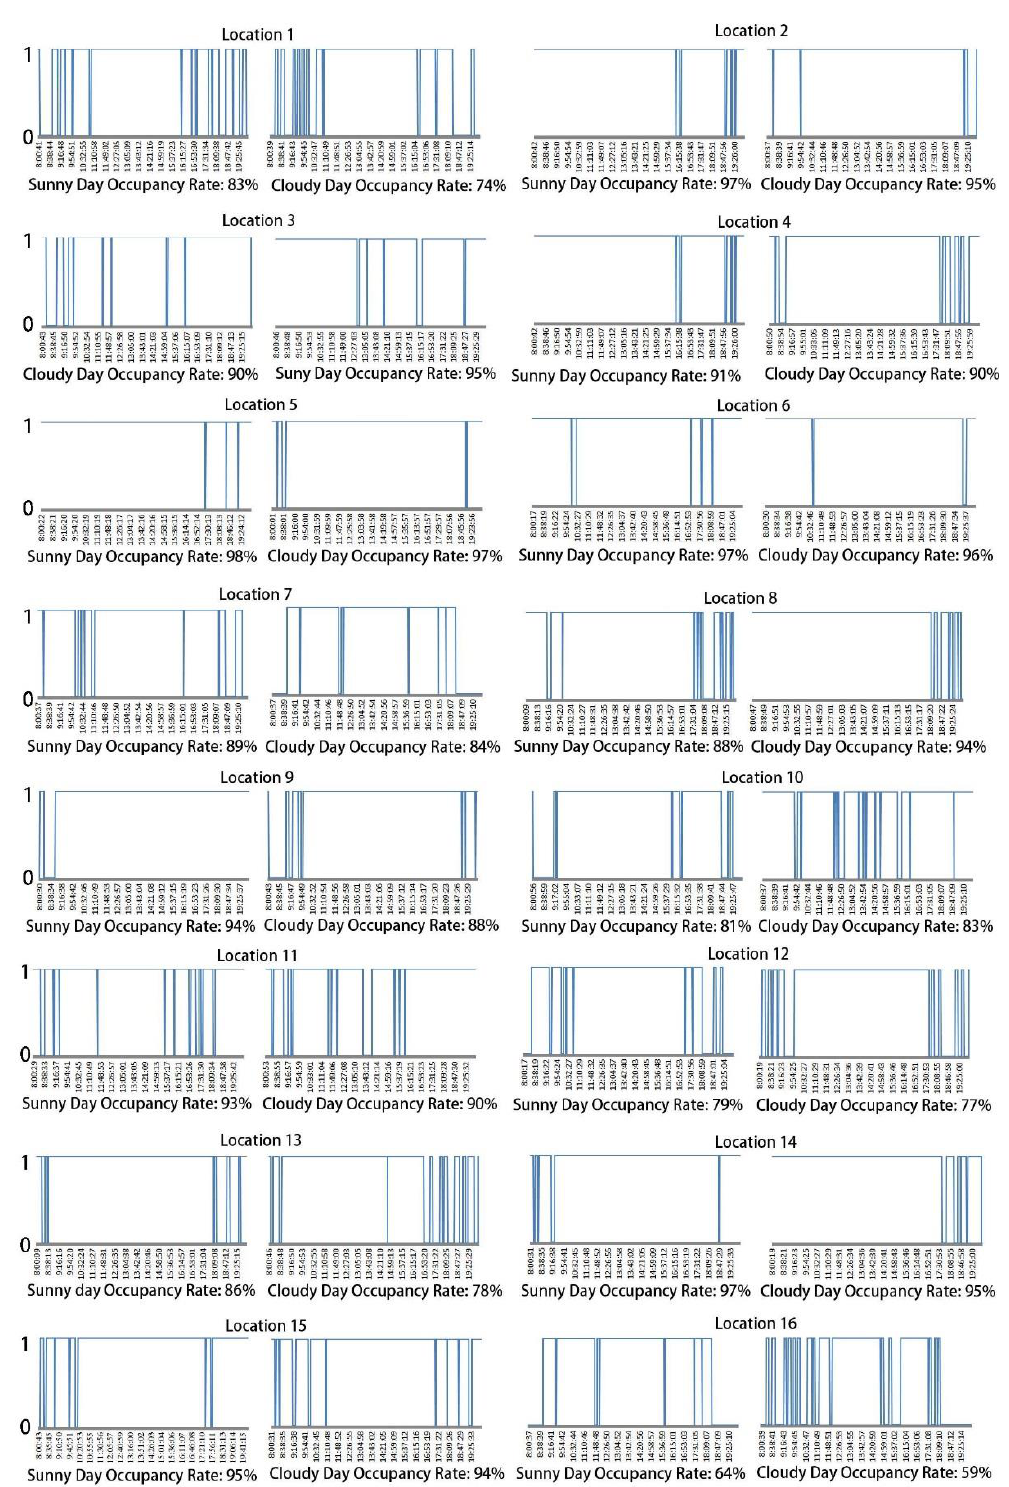
Figure 11. Occupancy rate at each location by PIR sensors (1: occupied; 0: unoccupied). Figure 12 further breaks down the occupancy data into different time slots. Step-by-step pair tests were conducted to see whether the difference was significant. In both days, the occupancy rate in